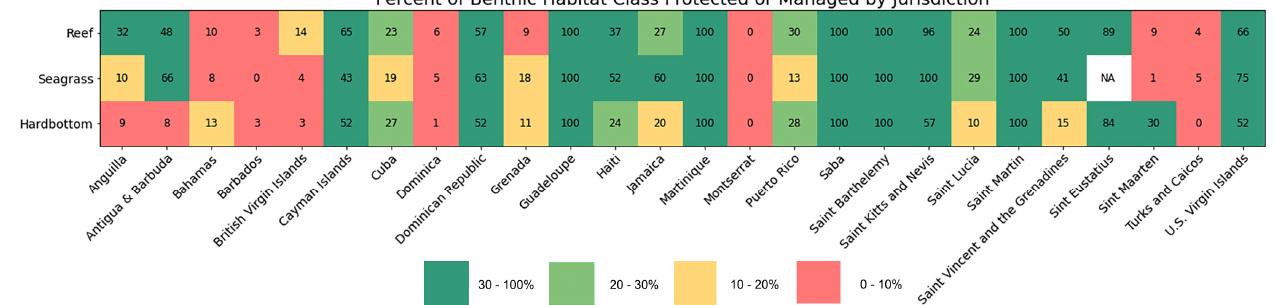
Figure 12. Percentage of major benthic habitat class (coral reef, seagrass, hardbottom) protected or managed by jurisdiction, based on The Nature Conservancy’s declared Caribbean marine protected or managed area database.